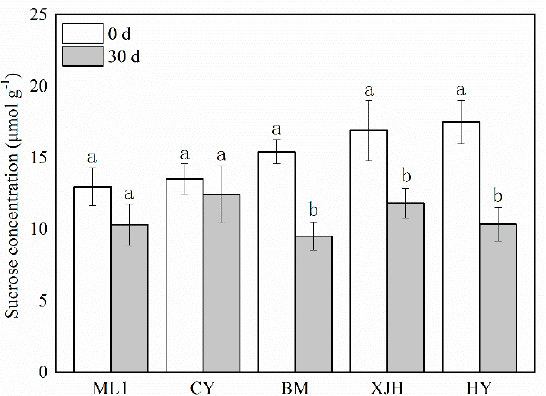
Figure 2. The content of sucrose in the phloem of five kiwifruit cultivars canes after 30 days of inoc- ulation of Pseudomonas syringae pv. actinidiae (Psa). The data represent means from three biological replicates. Error bars = SD. Columns with different letters are significantly different at p < 0.05.